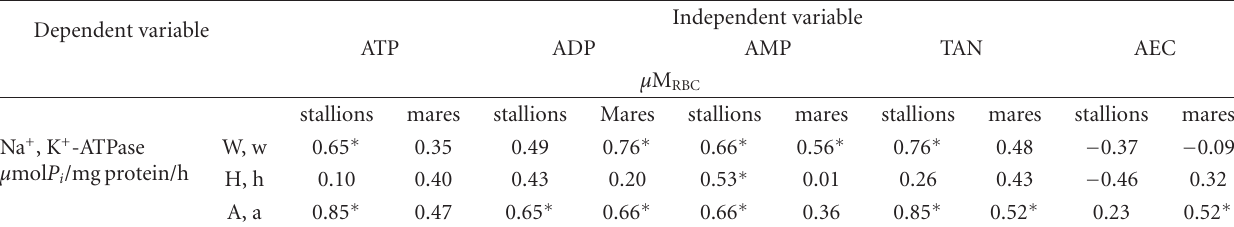
Table 5: Correlation coe ffi cient ( r ) between adenine nucleotides concentration ( µ M), total adenylate nucleotide pool (TAN), values of the adenylate energy charge (AEC) in erythrocytes and the Na + , K + -ATPase activities of stallions and mares Wielkopolska breed (W, w), Hanoverian breed (H, h), Ardenian breed (A, a); ∗ -significant di ff erence ( P < . 05 ).